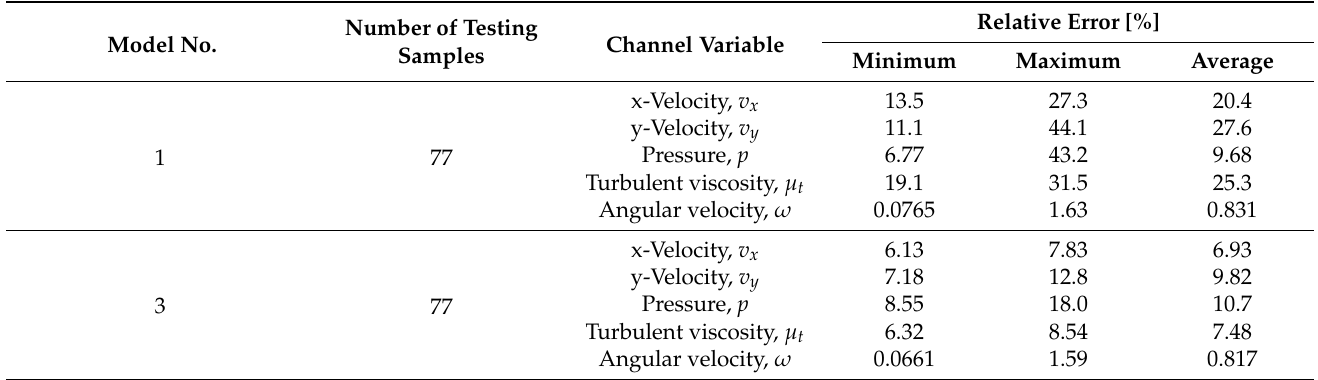
Table 11. Relative errors produced by Model 1 and Model 3, for the combined testing cases of v ∞ = 2.0 and 2.5 m/s.